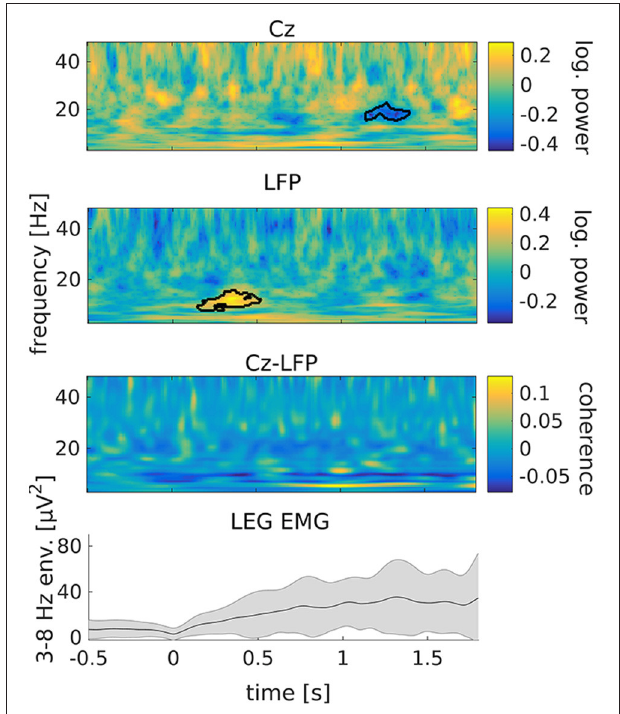
FIGURE 3 | Tremor onset is associated with a transient increase of subthalamic power at alpha/low beta frequencies. From top to bottom: cortical power, STN power, STN-cortex coherence and leg EMG power between 3 and 8Hz. Time 0 marks tremor onset. Colors indicate the difference to baseline ( − 0.65 to − 0.15s relative to tremor onset). The black outline marks significant differences. The gray shading in the lowermost plot illustrates the standard deviation across tremor epochs.